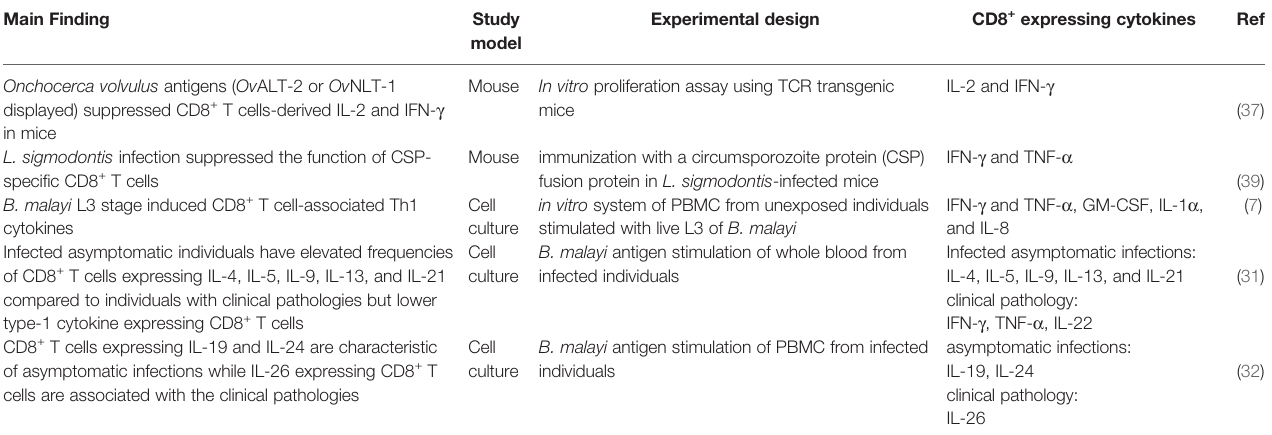
TABLE 1 | CD8 + T cells expressing cytokines in response to fi laria